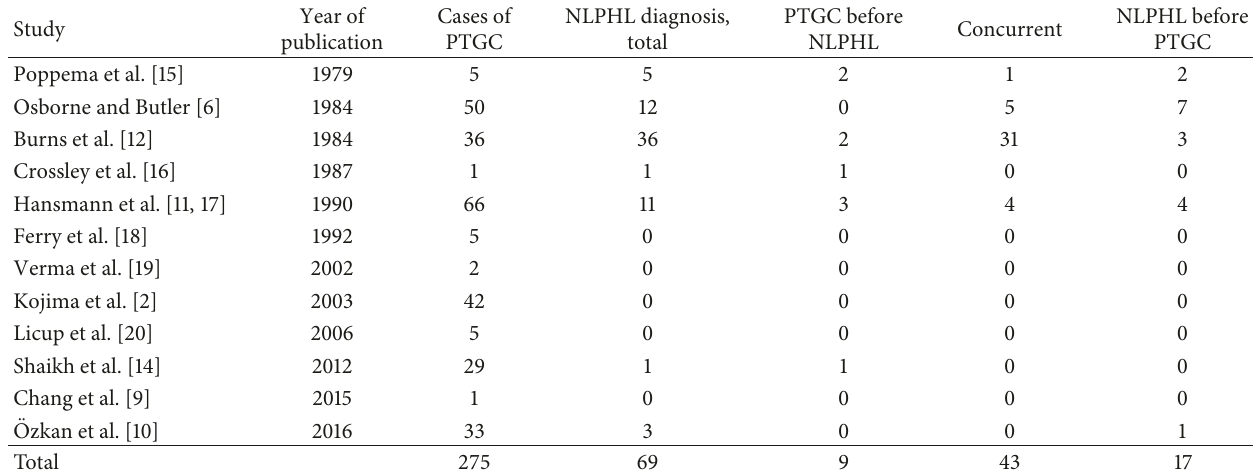
Table 1: Summary of